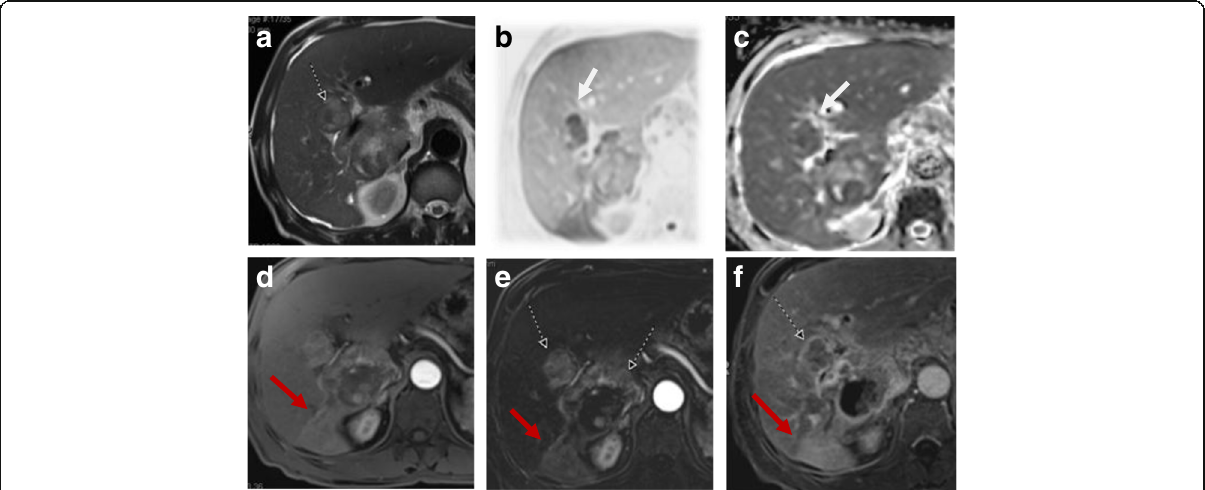
Fig. 7 Hepatic focal lesion after TACE. a T2-WI shows two well-defined HFLs of an intermediate to high signal. b , c DWI and ADC show central areas of true restriction for the smaller lesion (arrow) and heterogeneous restriction for the larger one. d Enhanced T1-WI in the arterial phase shows early arterial heterogeneous enhancement. e Subtracted T1-WI arterial phase shows true enhancement of the lesions (dashed arrows). There is a wedge area of enhancement as well (red arrow). f Enhanced T1-WI in the delayed phase shows washout with capsule enhancement (dashed arrow). The wedge enhancement shows delayed T1-WI persistent enhancement (red arrow). Overall post-treatment assessment is LR-TR viable with post-therapy changes